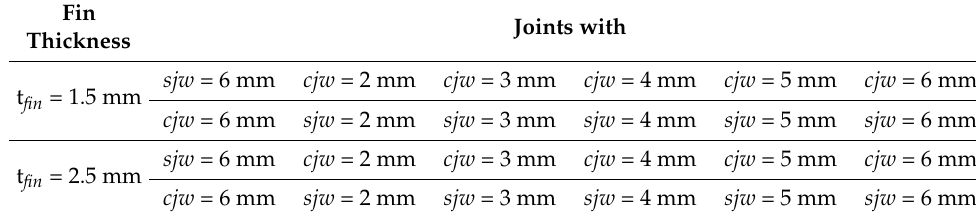
Table 1. The structure parameters of CJF.